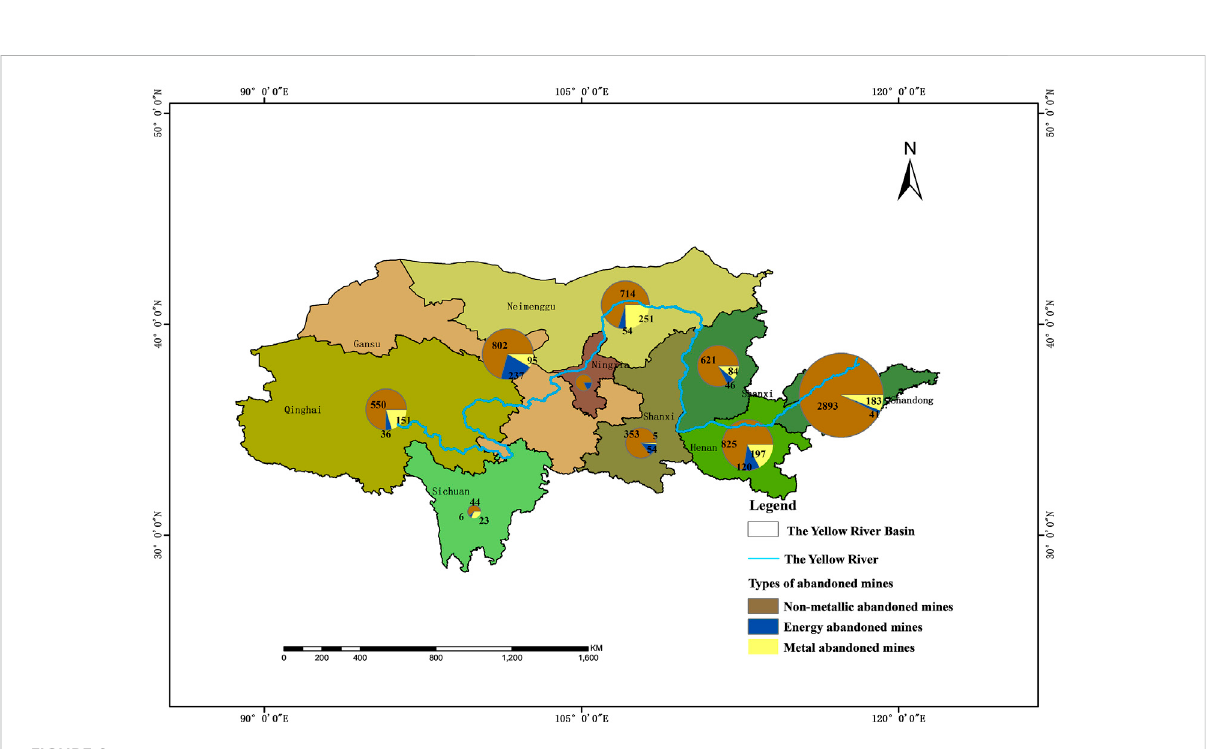
FIGURE 9 Spatial distribution of abandoned mines in the Yellow River